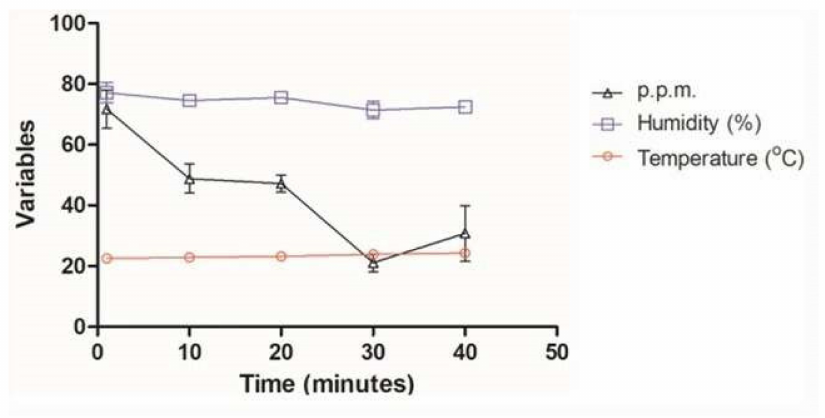
Figure 2. Average temperature, relative humidity, and ozone concentration at times of 1, 10, 20, 30, and 40 min with ATCC ( S. aureus (ATCC 6538), P. aeruginosa (ATCC 15442), S. enterica (ATCC) strains 10708), and E. coli (ATCC 25922)) and multidrug-resistant S. aureus (MRSA), P. aeruginosa (XDR), A. baumannii (PDR), and K. pneumoniae